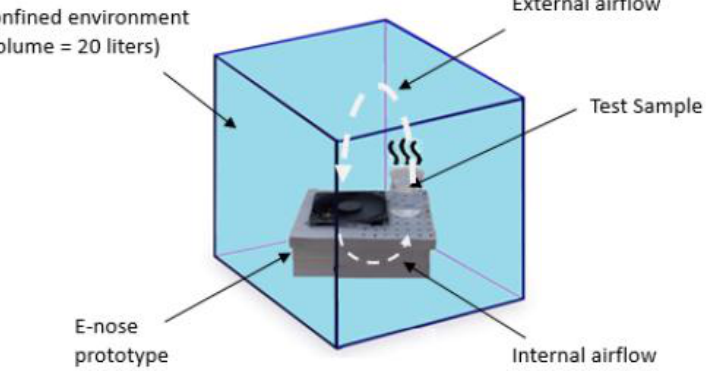
Figure 4. Standard solution sampling step.